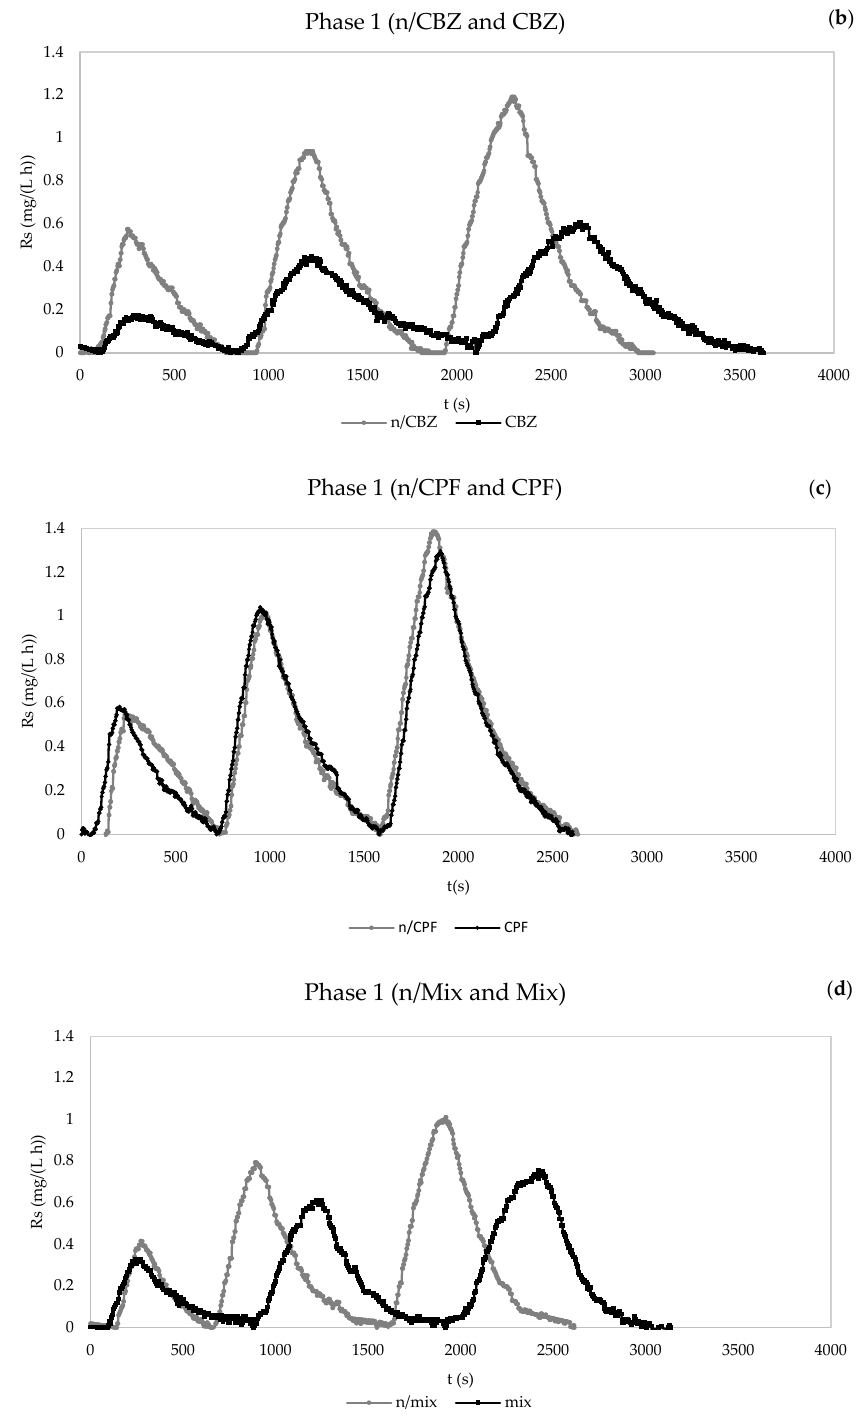
Figure 4. Evolution of dynamic oxygen uptake rate (R s ) in the respirometric experiments in the absence and presence of pollutants for the determination of the kinetic parameters. ( a ) Phase 1: control without BPA and with BPA. ( b ) Phase 1: control without carbamazepine and with carbamazepine. ( c ) Phase 1: control without ciprofloxacin and with ciprofloxacin. ( d ) Phase 1: control without pharmaceuticals and with mixture of pharmaceuticals. n/BPA: absence of bisphenol A. BPA: presence of bisphenol A. n/CBZ: absence of carbamazepine. CBZ: presence of carbamazepine. n/CPF: absence of ciprofloxacin. CPF: presence of ciprofloxacin. n/Mix: absence of mix of pharmaceuticals. Mix: presence of mix of